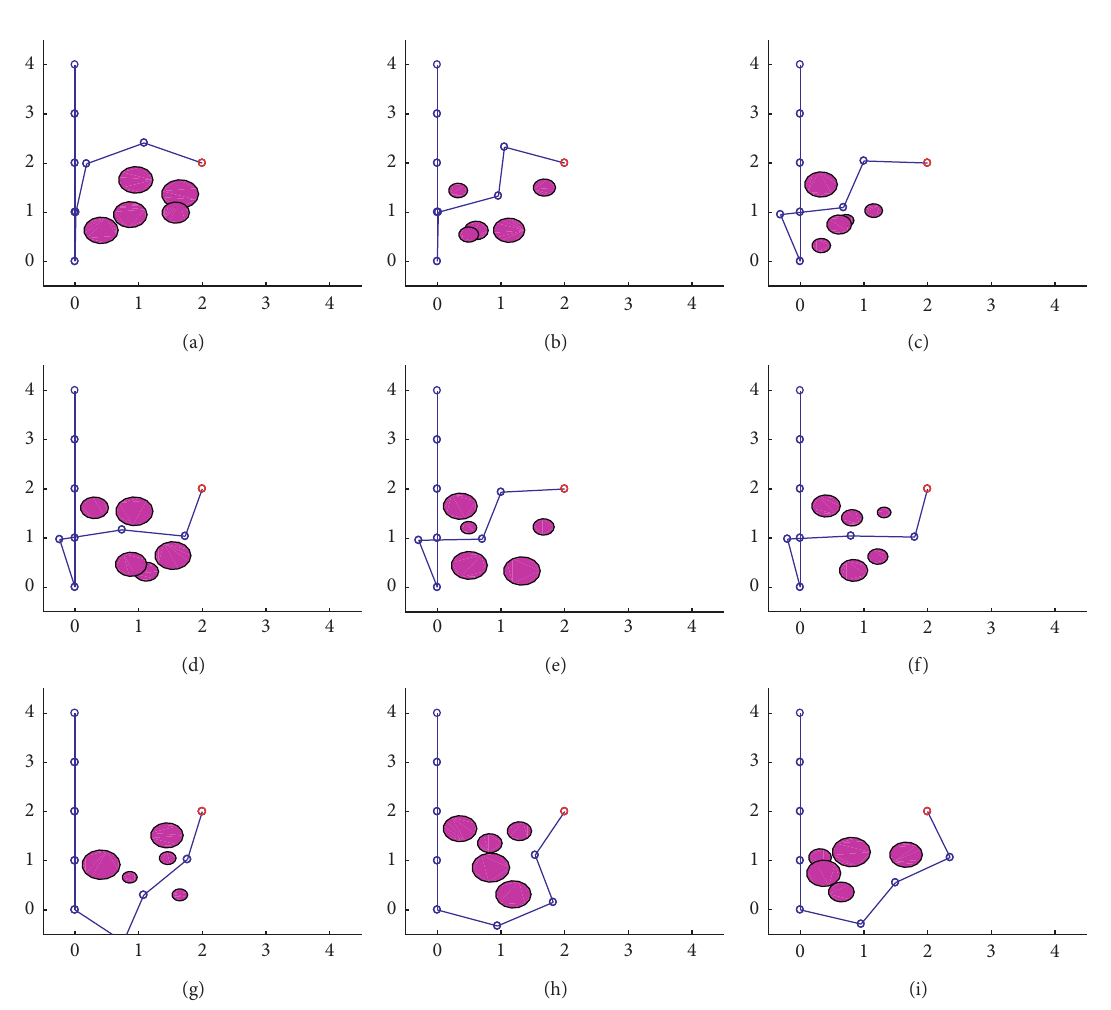
Figure 5: Visualization experiment results of extending FABRIK with obstacle avoidance in test